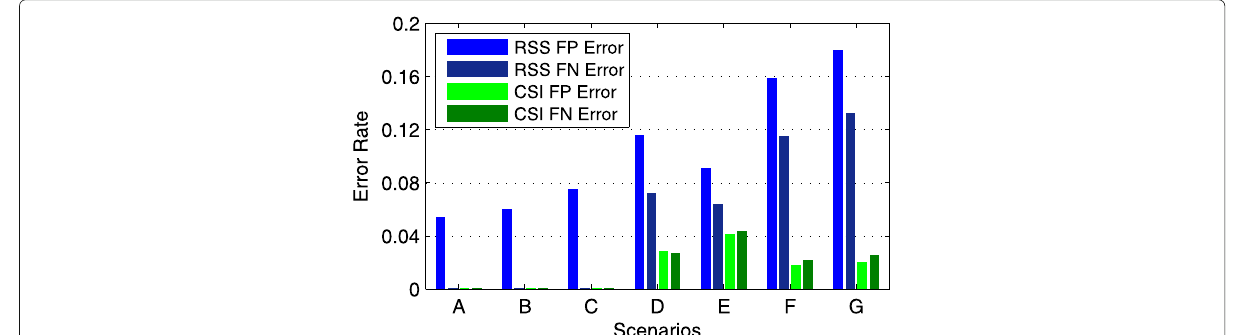
Fig. 5 PHYAlert has better performance than the RSS-based approach in terms of both FPE and